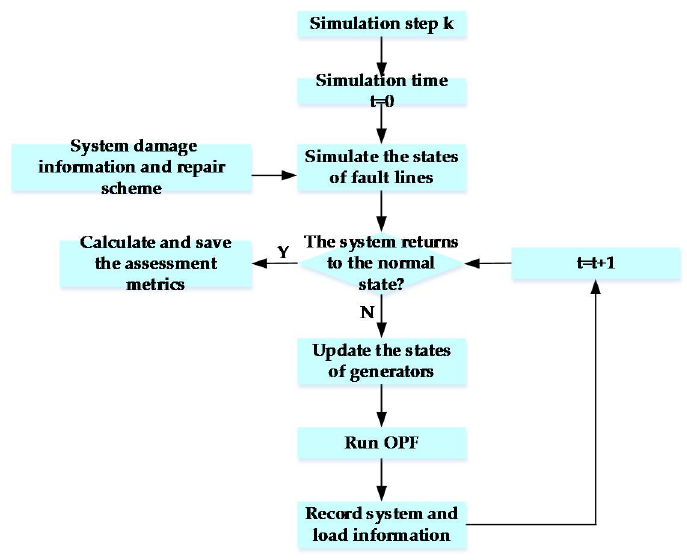
Figure 2. The simulation procedure for assessing system restoration ability.